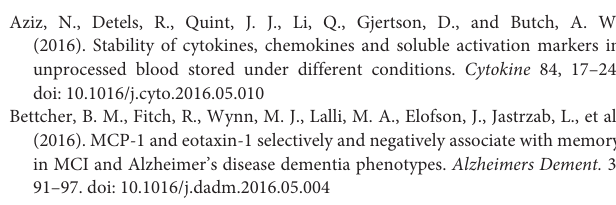
Figure S1 | Summarized information on demographics of donors used for analysis of (A) fresh-frozen plasma (FFP), (B) erythrocyte concentrate (EC) and (C) platelet concentrate